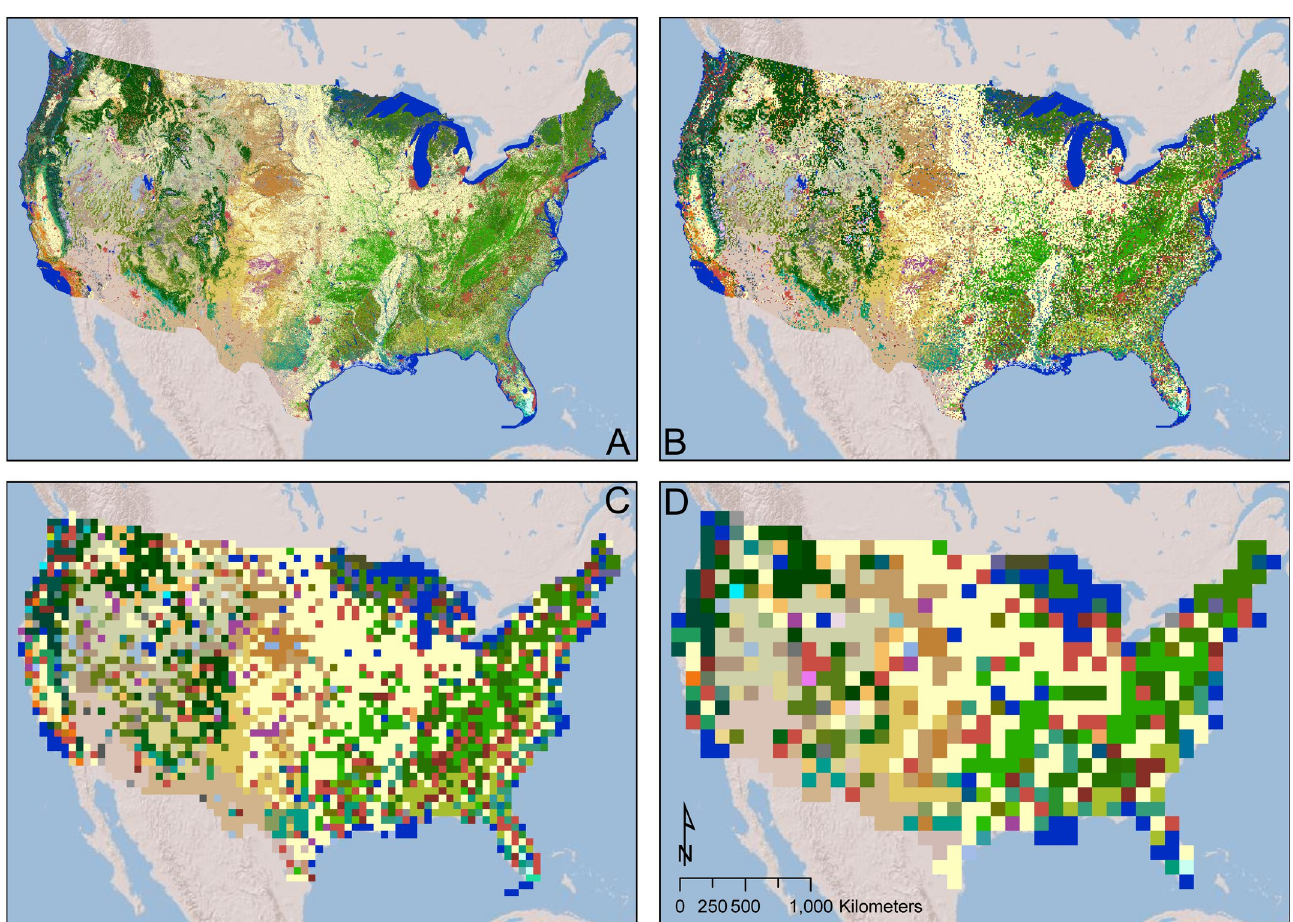
Fig 8. The effect of grid size on data visibility. Modern 30 x 30 m landcover data from the GAP/LANDFIRE National Terrestrial Ecosystems data set (courtesy of the U.S. Geological Survey - https://doi.org/10.5066/F7ZS2TM0) (A), aggregated via majority rule to 8 x 8 km (B), .5˚ x .5˚ (C), and 1˚ x 1˚ (D) grids.